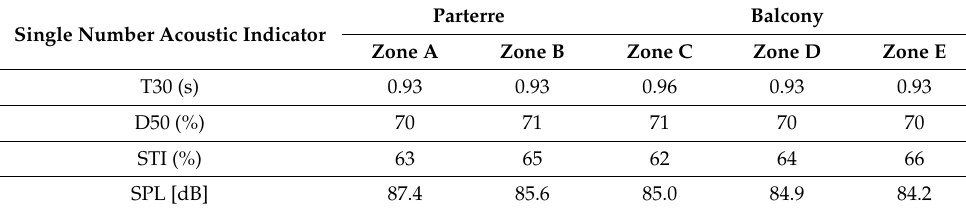
Table 10. Spatial distribution of acoustic indicators for configuration A.